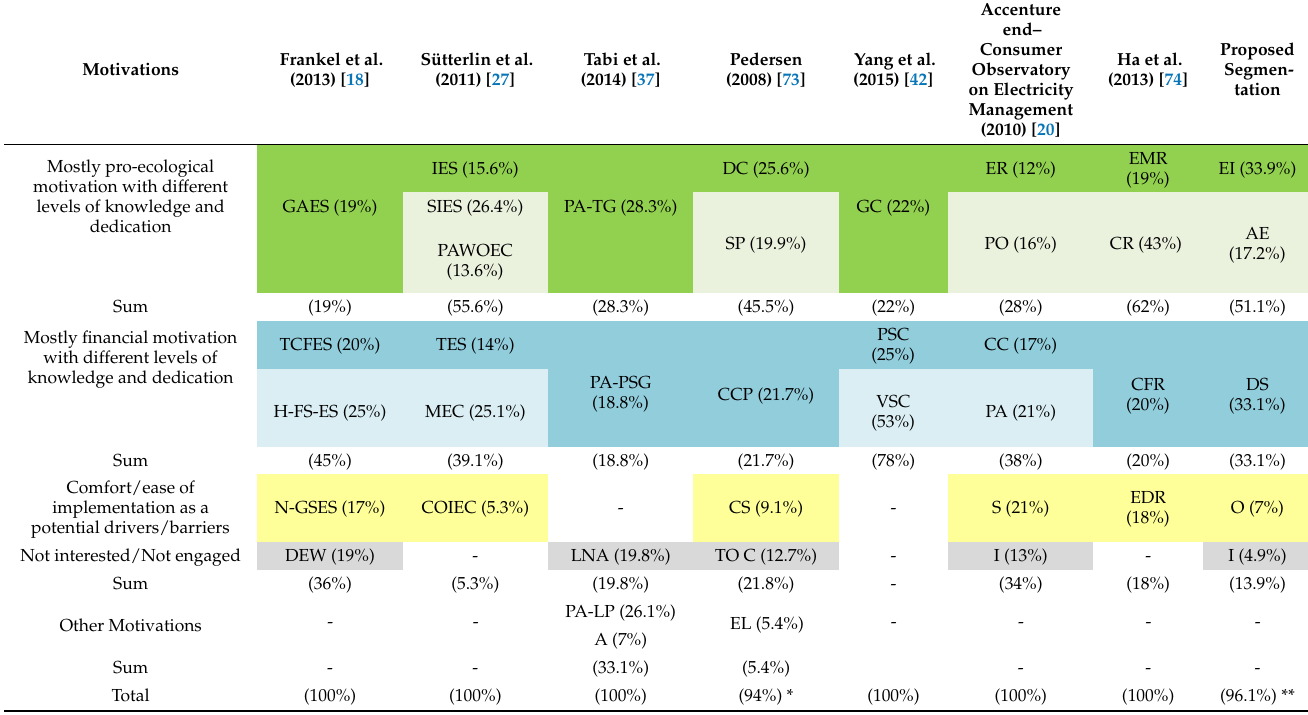
Table 8. Comparison of the different segments with the proposed segmentation.